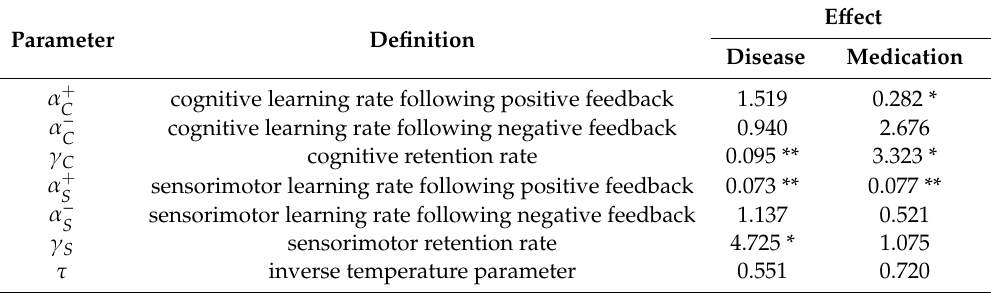
Table 3. Bayes factors for e ff ects of disease and medication on model